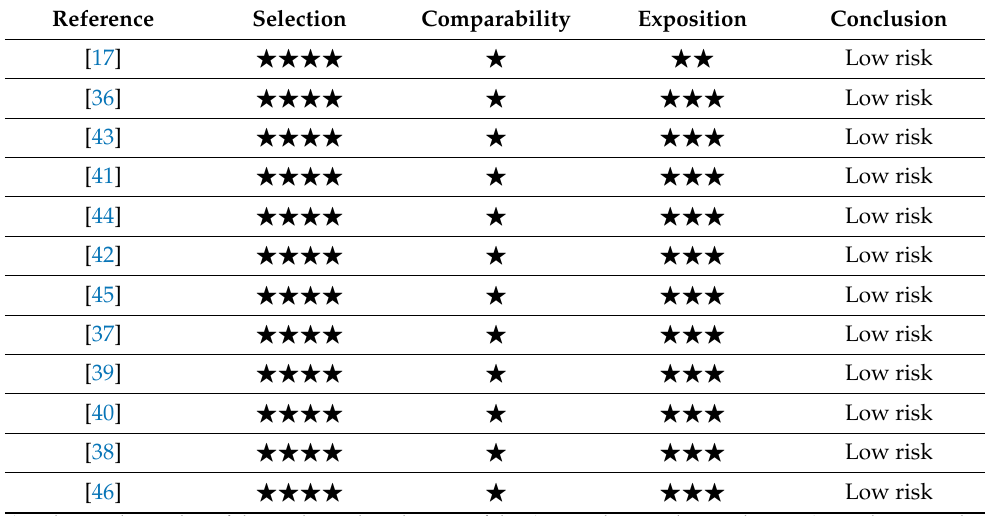
Table 3. NOS risk of bias